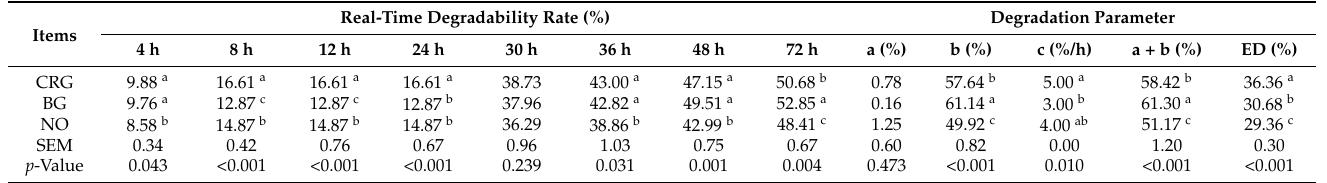
Table 5. Rumen real-time degradability and degradation parameters of NDF for three forages (CRG, BG and NO). Real-Time Degradability Rate (%) Degradation Items